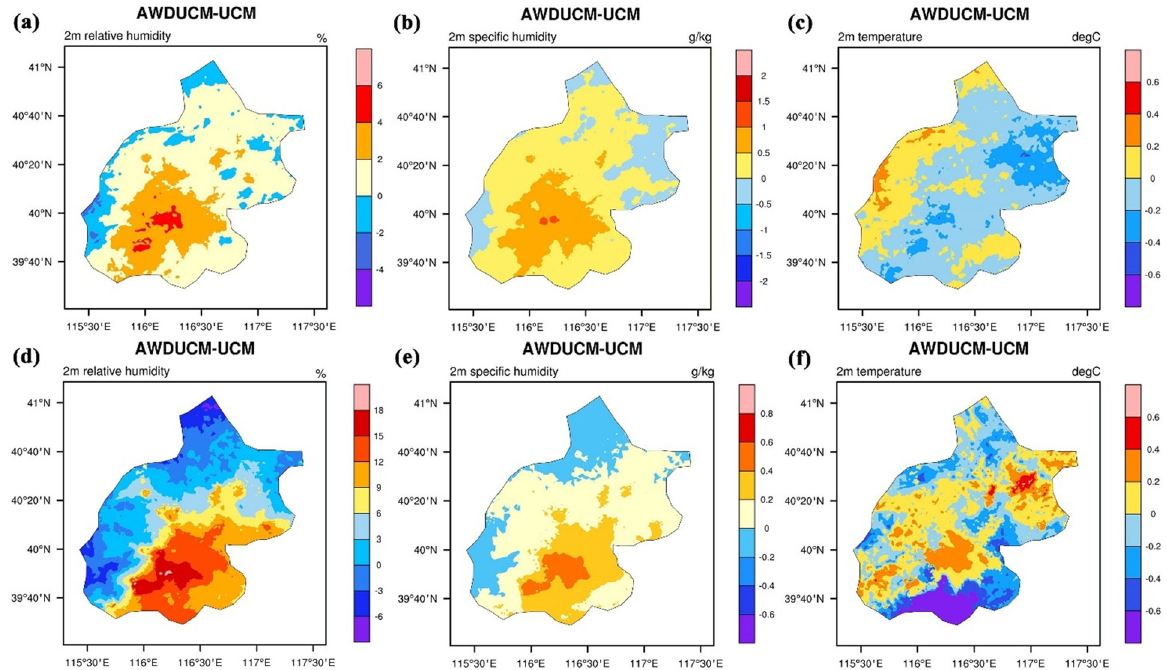
Fig. 6 The impact of arti fi cial water dissipation. Differences in mean 2 m relative humidity ( a and d ), speci fi c humidity ( b and e ), and temperature ( c and f ) between simulations that did and did not consider arti fi cial water dissipation during summer ( a , b , and c ) and winter ( d , e , and f ).